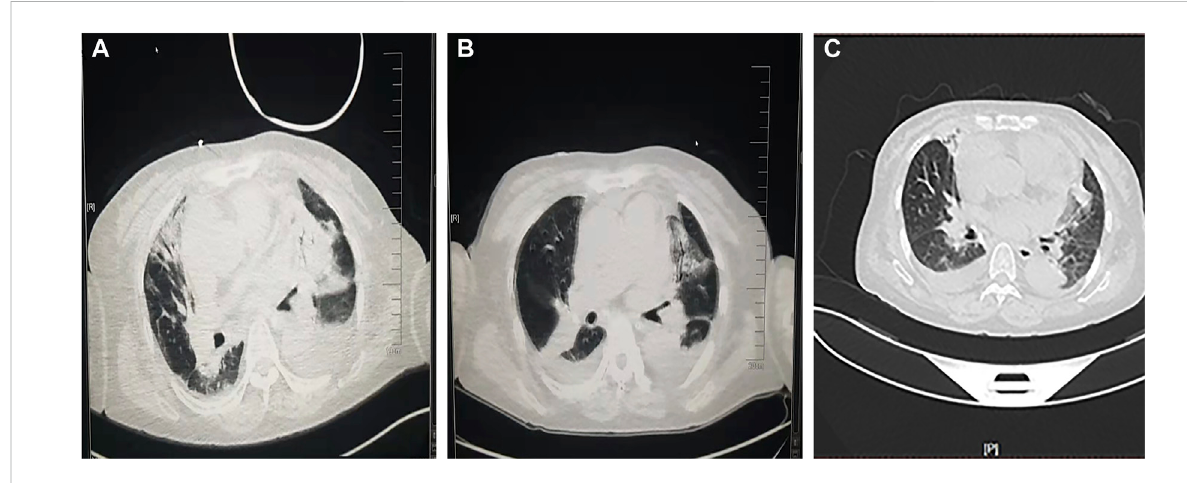
FIGURE 3 A comparison of pulmonary computed tomography (A) before glucocorticoids administration, (B) after weaning, and (C) before